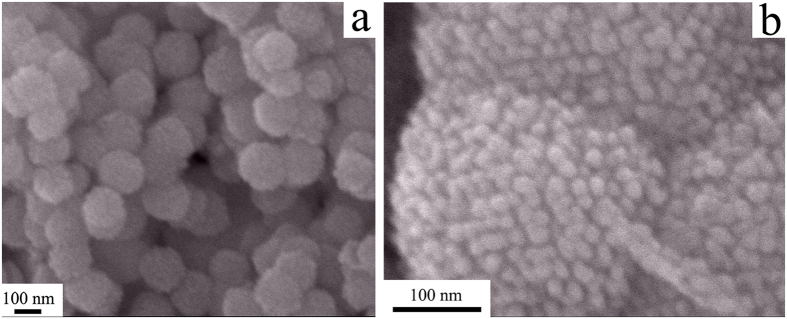
SEM images for mesoporous Co3O4.